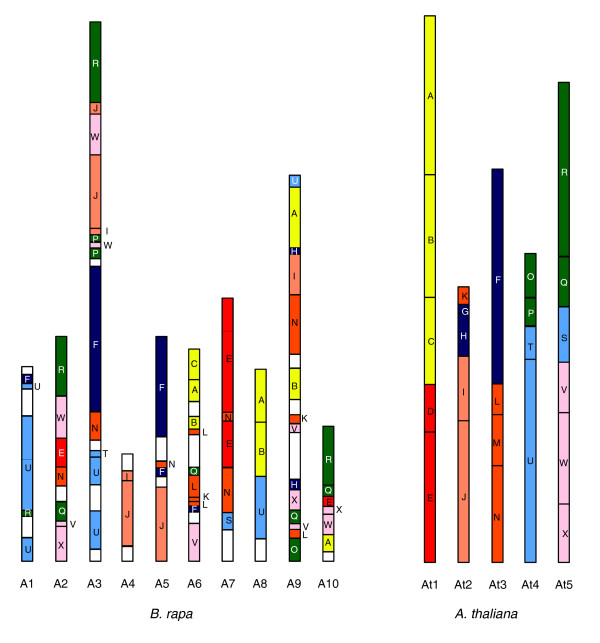
Comparison of the genome structures of B. rapa and A. thaliana based on 24 ancestral karyotype genome building blocks. The genome structure of At was based on the reports of Schranz et al. [37] and Lysak et al. [38]. The position of genome blocks in the Br chromosome was defined by a comparison of Br-At syntenic relationships and the At-AK mapping results. Br sequences were connected to form continuous sequences. Block boundaries, orientation, and gaps between syntenic blocks are shown in Additional data file 4. Each color corresponds to a syntenic region between genomes. The Br genome is triplicated and more thoroughly rearranged than the At genome.